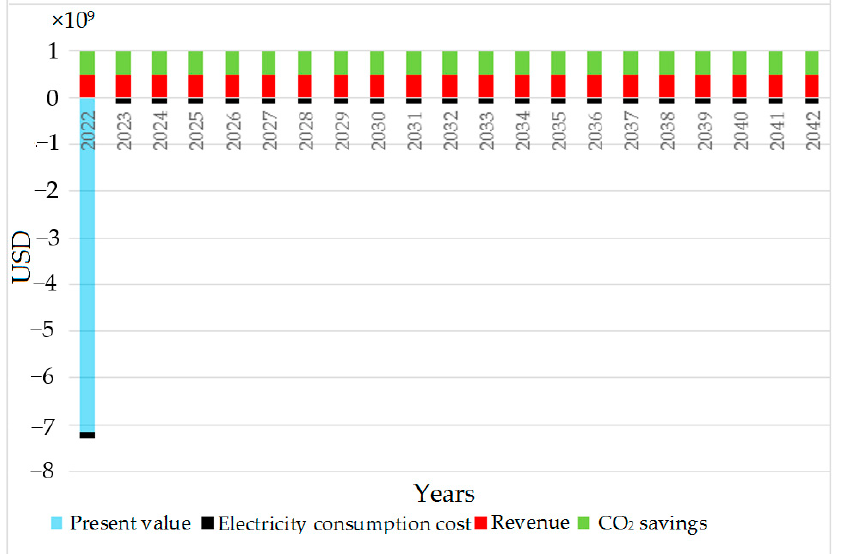
Figure 12. Cash flow for the second scenario when using a PV system as an electricity source.